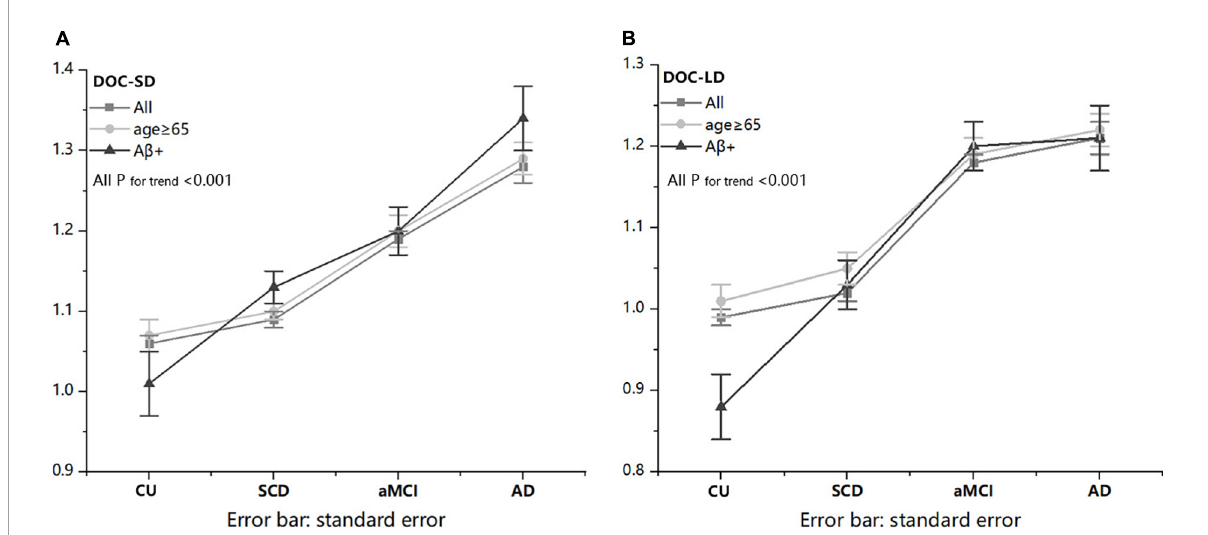
FIGURE2 An increasing trend of metamemory scores with the decline of cognitive state in all participants and two subgroups. ANCOVA analyses were performed on the metamemory scores, controlled by the influence of age and education years among four groups.